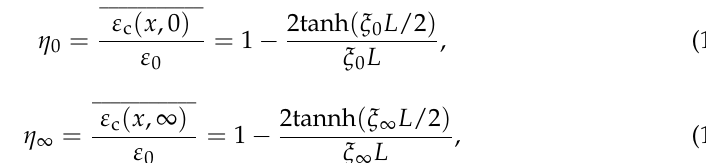
Figure 9. Schematic diagram of the test equipment connection. 4.2. Test Scheme The test scheme included the following five steps: 1.